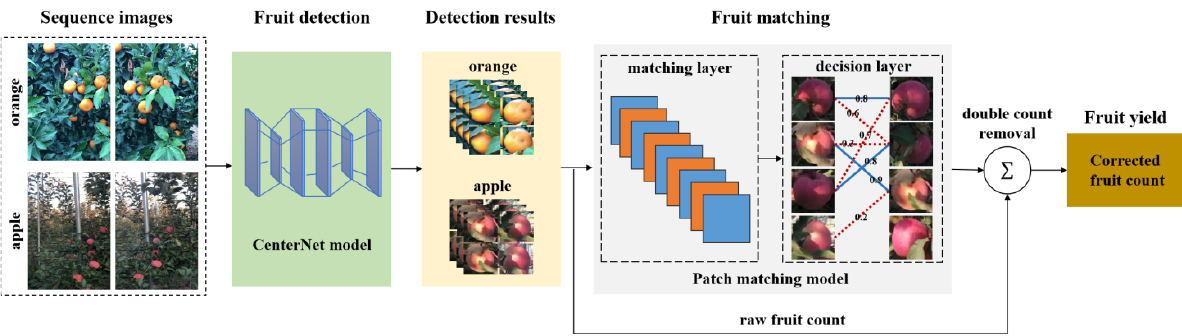
Figure 3. The workflow of the proposed method.